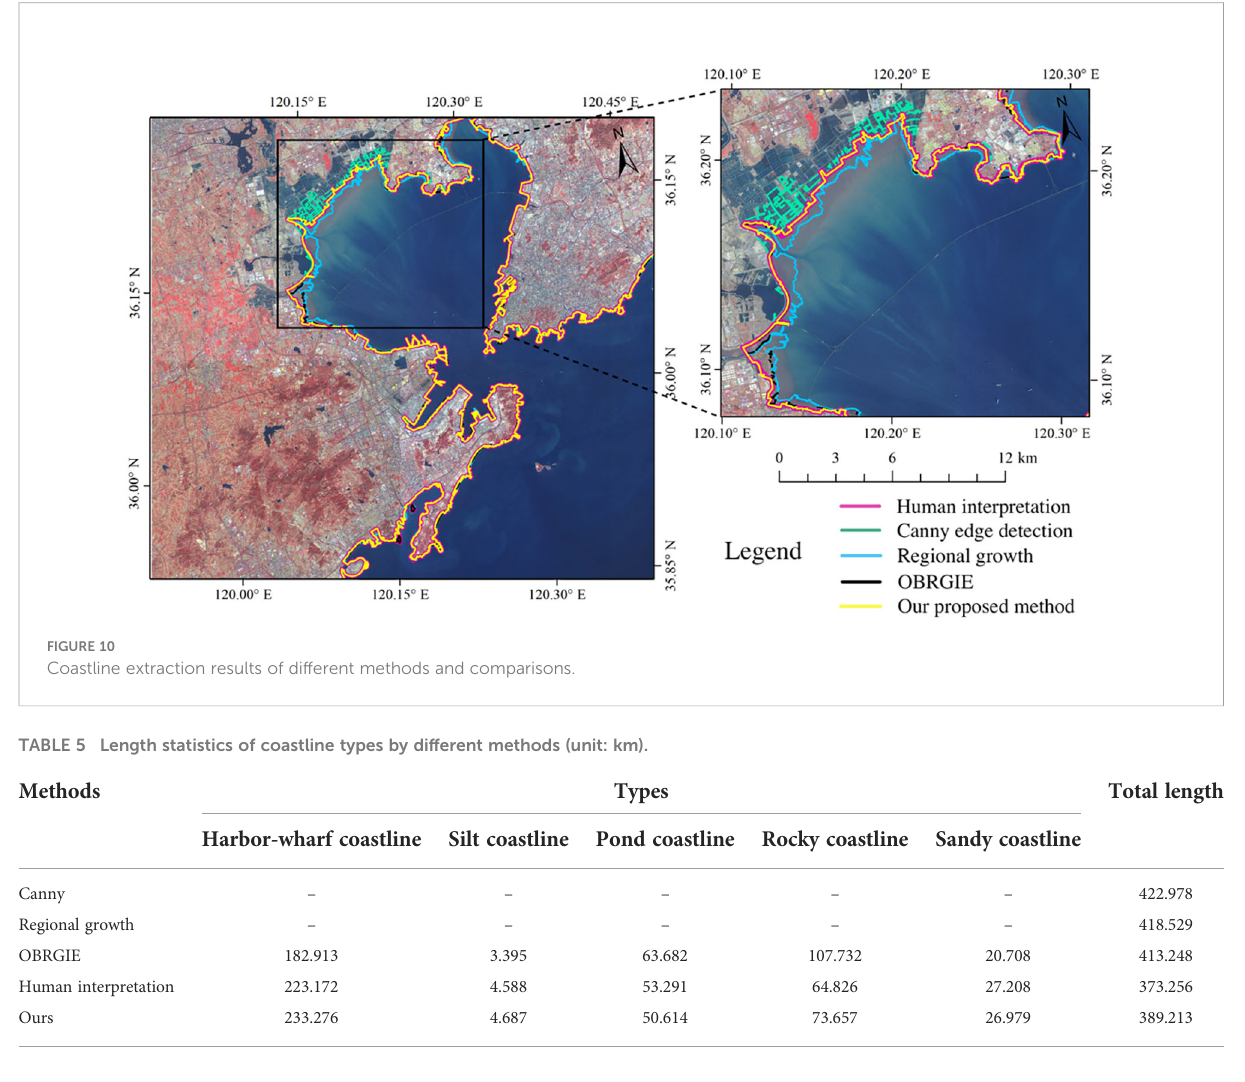
TABLE 6 Position accuracy of different methods (unit: m).